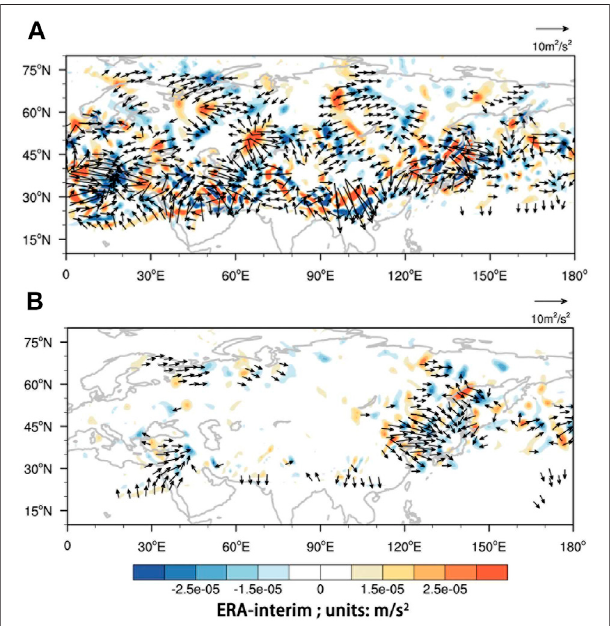
FIGURE 9 | The distributions of the WAF at 300 hPa (vectors; units: m 2 s − 2 )andtheWAFdivergence(shadings;units:m s − 2 )duringMeiyuperiods in (A) PHRE years and (B) non-PHRE years.